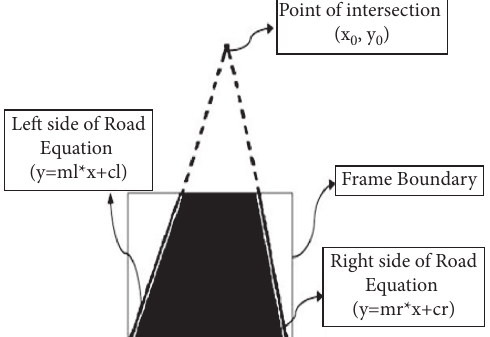
Figure 4: Illustration of the projection of parallel edges of the road backward to obtain the point of intersection.